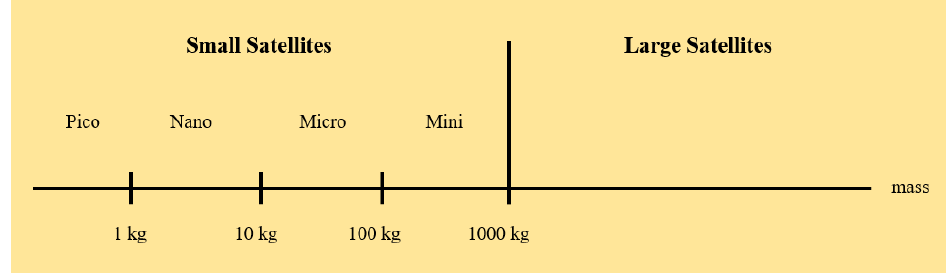
Figure 1. The satellite differentiation standard based on mass.